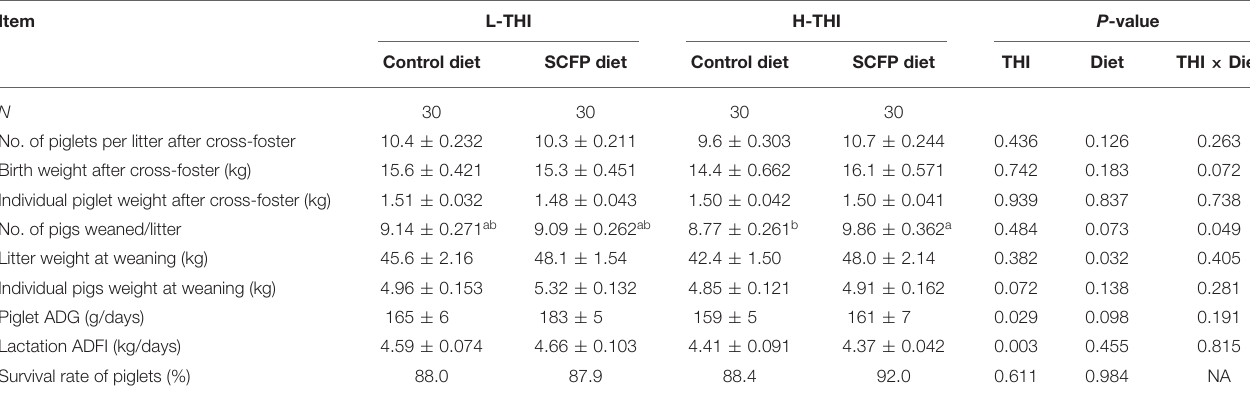
TABLE 4 | Effects of dietary supplementation of Saccharomyces cerevisiae fermentation product during late pregnancy and lactation on lactation performance of sows in a subtropical climate (Mean ± SE) *